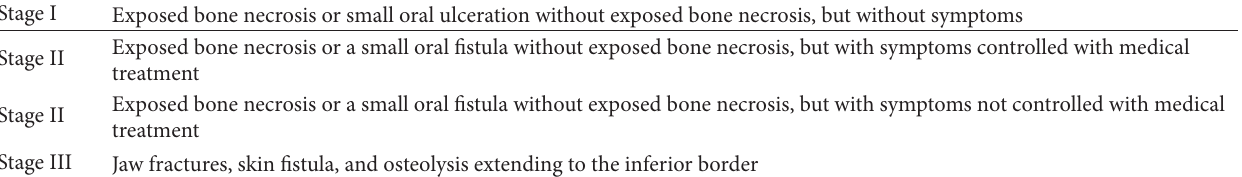
Table 2: Clinical staging and management strategies by Bagan et al. [22]